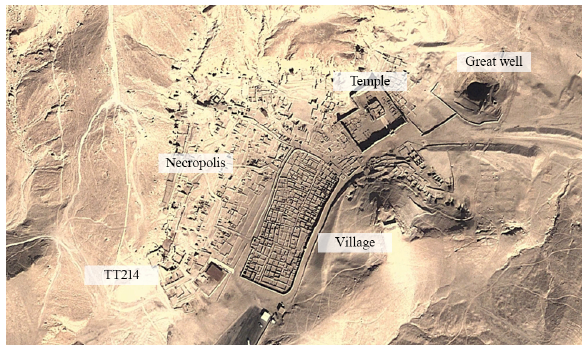
Figure 1 . Deir al-Medina, Egypt, seen from the air. The position of TT214 is visible in the south-west